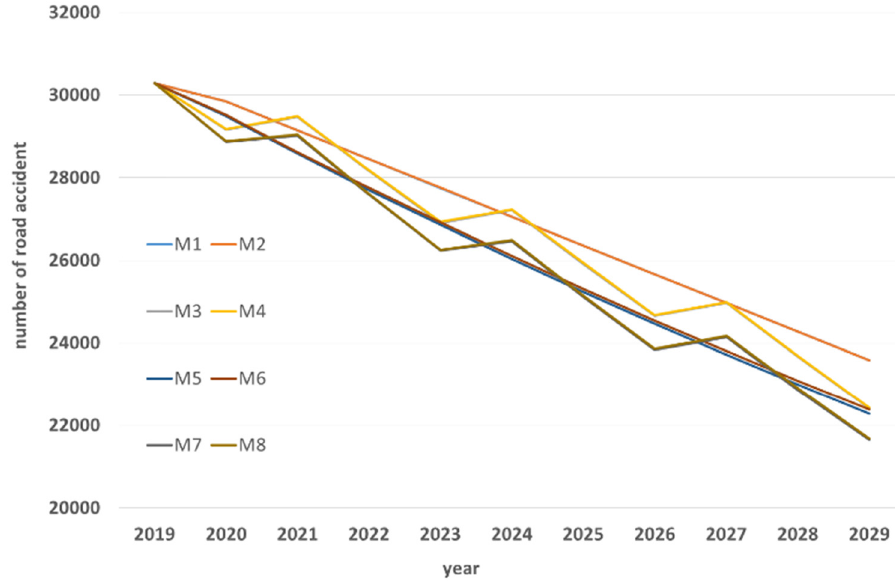
Figure 5: Forecasting the number of road accidents in Poland in 2020 – 2029 if there was no pandemic.